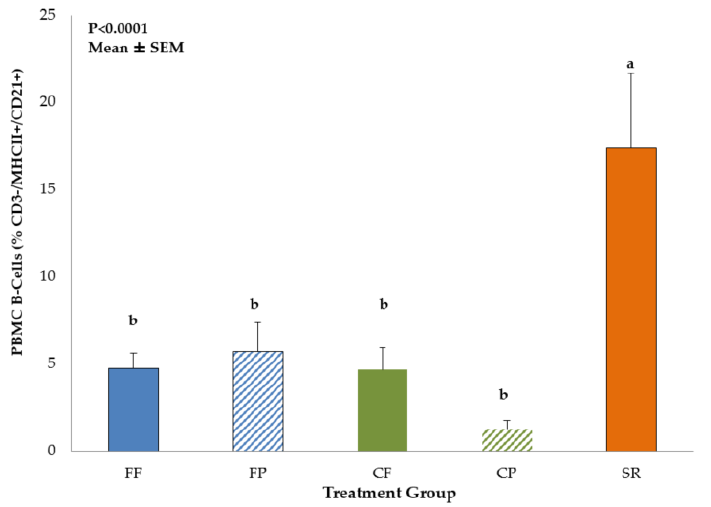
Figure 3. B-cells in PBMC of 21-day-old piglets fed different diets. SR had higher populations of circulating B-cells (CD3 − /MHCII + /CD21 + ) than all other diet groups. Values are mean ± SEM. Bars with different superscripts (e.g., a vs. b) indicate statistical significance at p < 0.05. Abbreviations: FF, formula-fed ( n = 12); FP, formula+prebiotic ( n = 9); CF, combination-fed ( n = 7); CP combination-fed+prebiotic ( n = 8); SR, sow-reared ( n = 7).